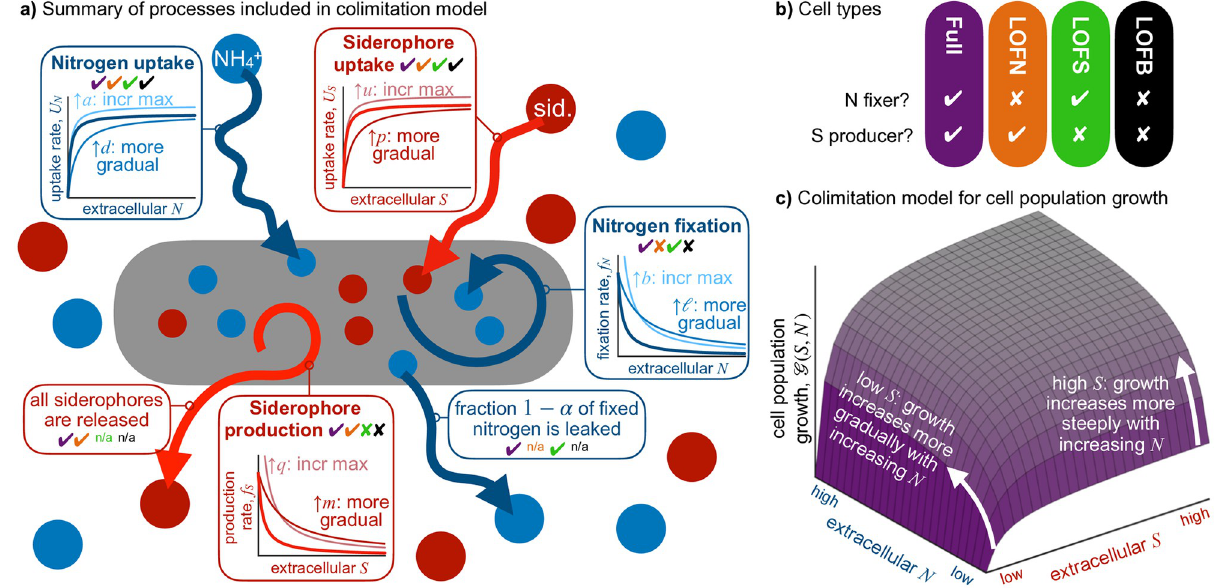
Fig 2. A broad overview of the colimitation model system. (a) We model cell populations that uptake, and may facultatively produce, nitrogen and siderophores at rates determined by the extracellular concentrations of these resources. The effects of increasing each production/uptake parameter, relative to the thickest curve, is shown. (b) We consider four different strains (functions performed by these strains marked with checks in (a), functions not performed marked with x’s): Full (fixes nitrogen and produces siderophores), LOFN (a LOF fixation mutant that only produces siderophores), LOFS (a LOF siderophore mutant that only fixes nitrogen), and LOFB (a LOF mutant that neither fixes nitrogen nor produces siderophores). (c) Because extracellular resource concentrations govern resource uptake and, when applicable, production, the cell population growth rate is also a function of extracellular resource concentrations. According to our colimitation model, availability of siderophores mediates the effect of fixed nitrogen on growth.